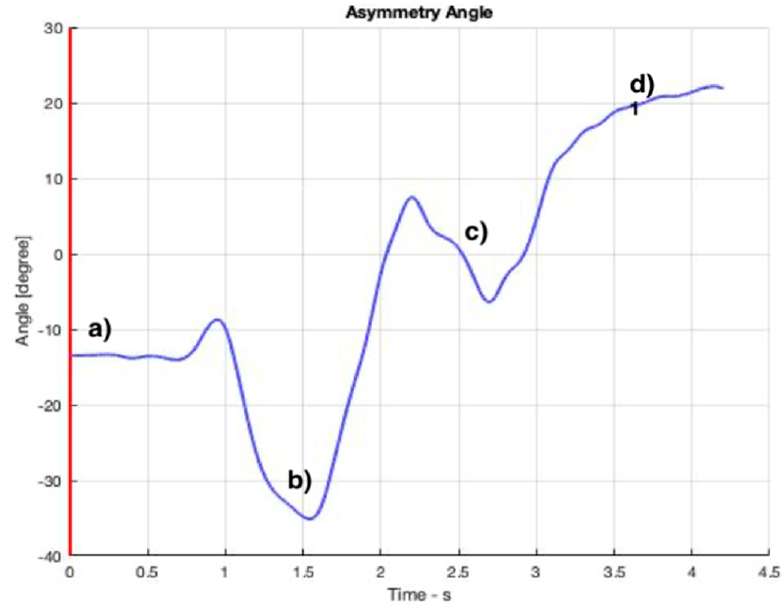
Figure 8. Value of the asymmetry angle throughout the OTP. The instants corresponding to the four snapshots in Figure 6 are indicated from ( a – d